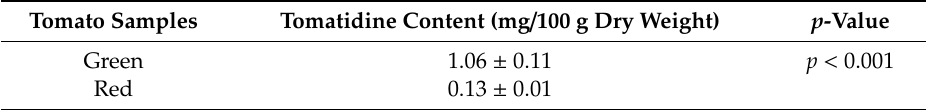
Table 2. Tomatidine contents of tomato fruits. Tomato